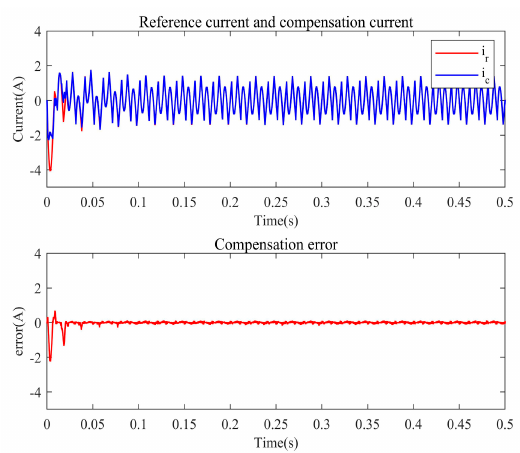
Figure 5. Current tracking comparison and tracking error curves. Table 1. System parameters in simulation.